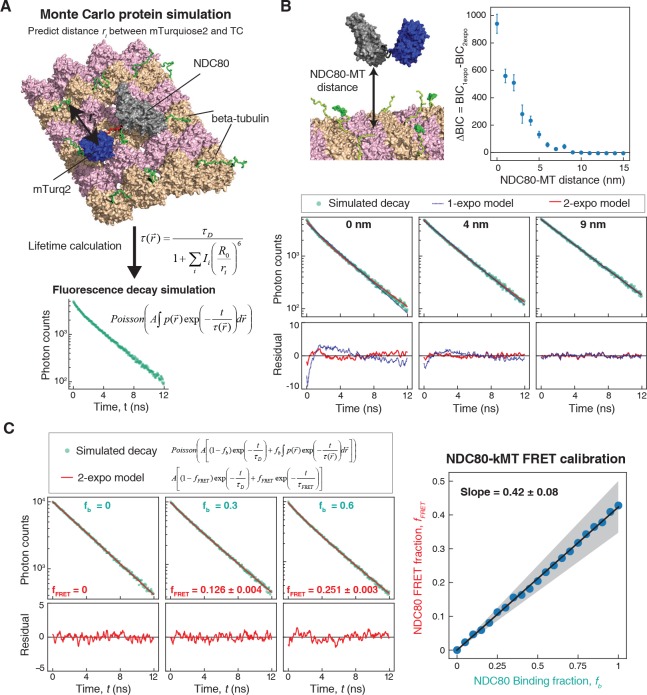
Characterization and calibration of NDC80-kMT FLIM-FRET measurement.(A) The conformational ensemble of the flexible tether between mTurquoise2 and Nuf2 (red) and the disordered C-terminal tails of beta-tubulins around the NDC80 (green) were modeled by large-scale Monte Carlo protein simulations, which were then used to calculate the distances, ri, between the mTurquoise2 and the TC motifs. FlAsH labeling was assigned to the TC motifs with 26.1% probability (which is the measured labeling fraction of beta-tubulin). Fluorescence lifetimes of the mTurquoise2 were calculated for randomly sampled sets of distances, r→=(ri), based on which fluorescence decay curves were simulated. (B) (top) Fluorescence decay curves for various distances between NDC80 and MT were simulated and then were fit using single- and two-exponential decay models. Difference in Bayesian information criteria (BIC) between single- and double-exponential models is plotted against the NDC80-MT distance. Data points are mean and SD. (bottom) Example simulated fluorescence decay curves (green dots) for 0, 4, and 9 nm NDC80-MT distances are plotted with the best-fit single- (blue line) and two-exponential (red line) models. Corresponding smoothened weighted residuals plotted below. (C) Fluorescence decay curves for various NDC80 binding fractions (fb) were simulated and fit by using two-exponential decay model to estimate FRET fraction (fFRET). (left) Three example simulated fluorescence decay curves (green dots) for 0, 30, and 60% binding fractions with the best-fit two-exponential models (red line), and the corresponding smoothened weighted residuals plotted below. (right) NDC80 FRET fractions (fFRET) plotted against NDC80 binding fractions (fb) (blue dots), and the linear fit (black line). Gray-shaded area represents the uncertainty in the slope, which was determined from the uncertainties in the measured beta-tubulin labeling fraction and Förster radius (see Supplemental experiments in Materials and methods).